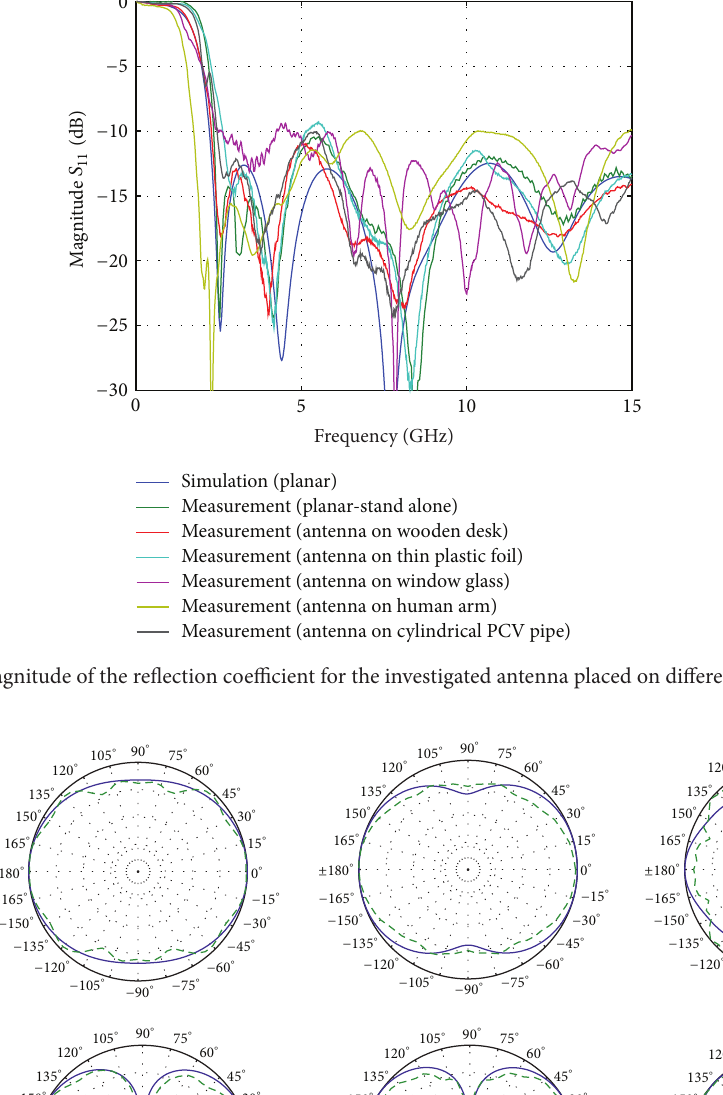
𝑠 = 𝑠 = 2.28 mm, 𝑠 𝑐1 𝑐3 = 0.33 𝑙 𝑐2